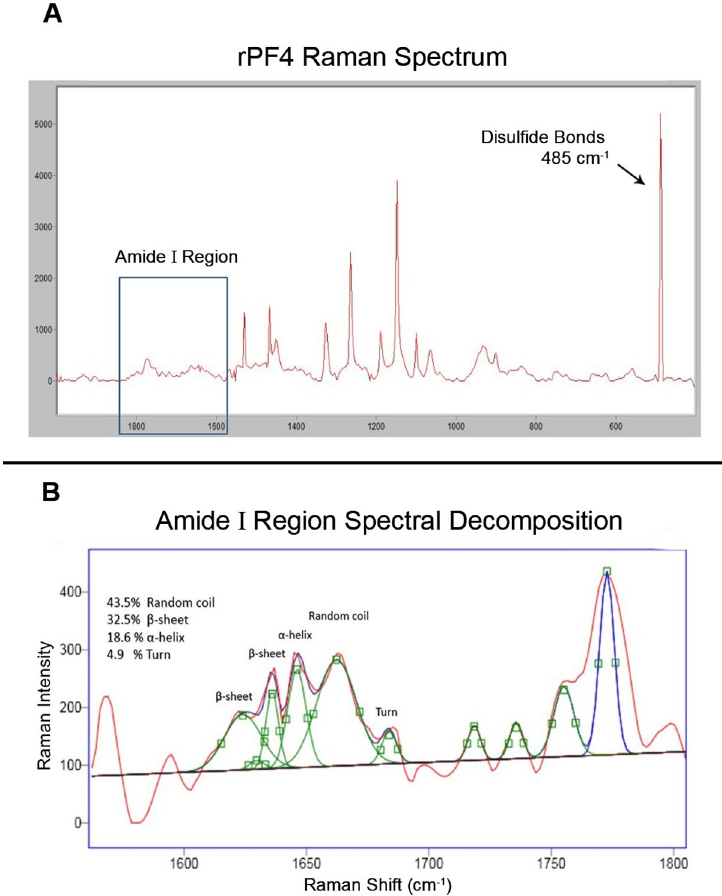
Fig 15. Investigation of the secreted rPF4 secondary structure composition and disulfide bond formation. By exploiting Raman spectroscopy, the conformation of the secreted rPF4 was analyzed. (A) Represents disulfide bond formation at the 485 cm -1 of Raman shift. (B) Following decomposition of the amide I region, the secondary structure composition of the rPF4 was revealed to be in near perfect agreement with predictions based on x-ray crystallography